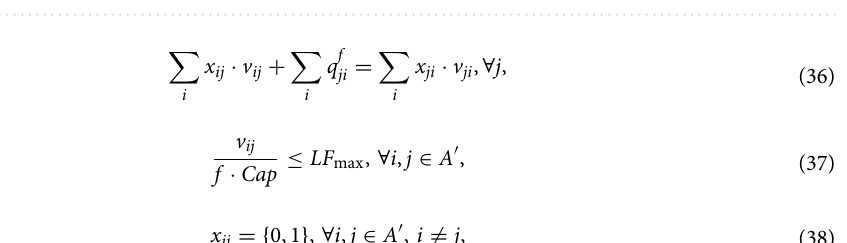
Figure 3. Sioux-Falls road and transit